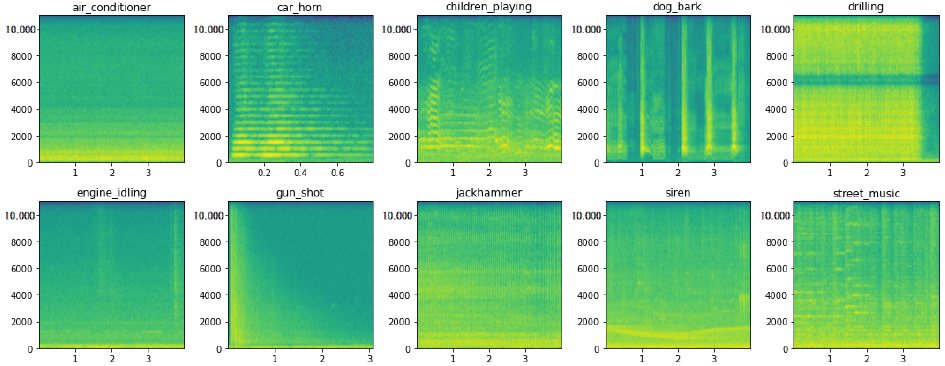
Figure 4. Illustrations of the log-Mel-Spectrogram samples from each class of the Urban- Sound8K